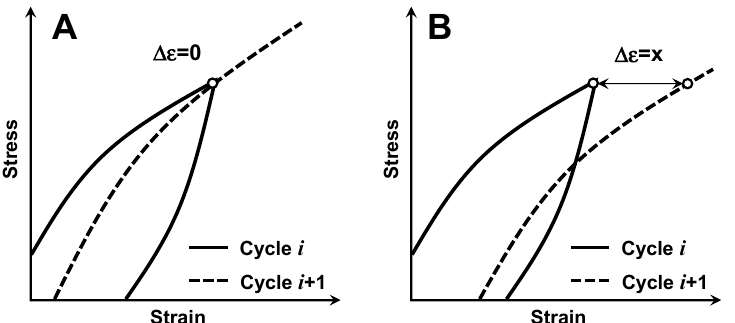
Figure 5. A schematic presentation of cyclic stress–strain deformation behavior indicating absence of creep strain shift ∆ ε = 0 ( A ) and presence of creep strain shift ∆ ε = x ( B ). LaCoO 3 sample #2 was further cycled under the same loading conditions upon cooling from each elevated temperature test, and the results of these RT cycling tests are shown in Figure 4B. As can see from Figure 4B, the RT deformation behavior of LaCoO 3 is different and strongly depends on the proceeding high temperature cyclic test. Among these three selected high temperatures, the RT hysteresis loops had the smallest areas after testing at 400 ◦ C, with a progressive increase in the hysteresis loop areas after testing at 800 ◦ C and especially at 900 ◦ C. For example, the RT hysteresis loop areas in the fourth